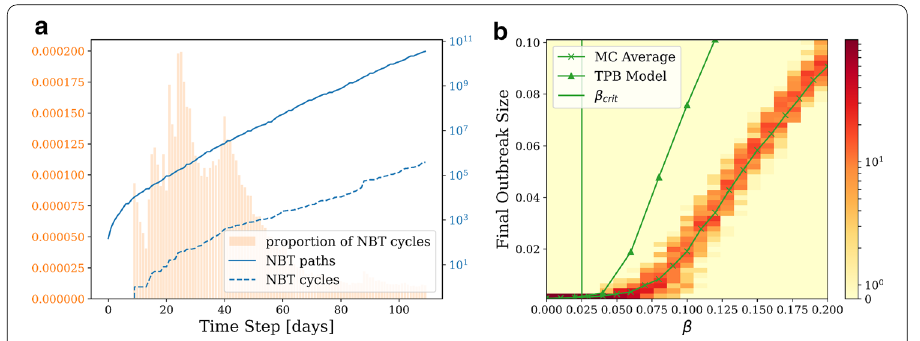
Fig. 5 a Proportion (bars) and number of all non-backtracking (NBT) paths (blue solid) and cycles (blue dashed) that close at each respective time step. b Final outbreak sizes for varying values of β with µ = 0.005 . The vertical line shows the critical probability β crit obtained from the TPB model. The average of the Monte-Carlo (MC) is shown as green